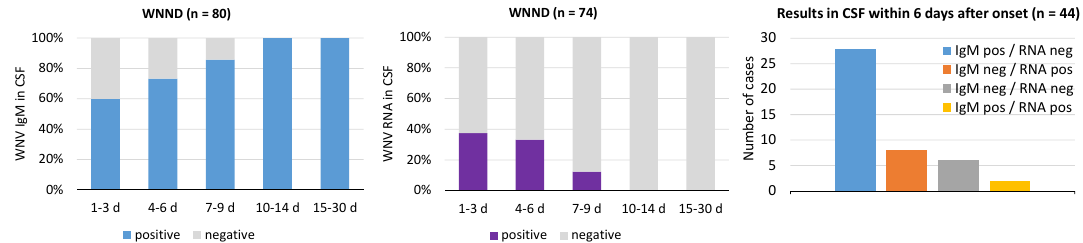
Figure 7. Laboratory findings in cerebrospinal fluid (CSF) samples collected from patients with West Nile neuroinvasive disease (WNND), Veneto region, northern Italy, 2018. Graphs show the percentage of CSF samples positive for WNV IgM and WNV RNA according to the time since the onset of symptoms and the distribution of the WNV IgM and WNV RNA results in CSF collected during the first week after onset. The number of tested samples is indicated between brackets.